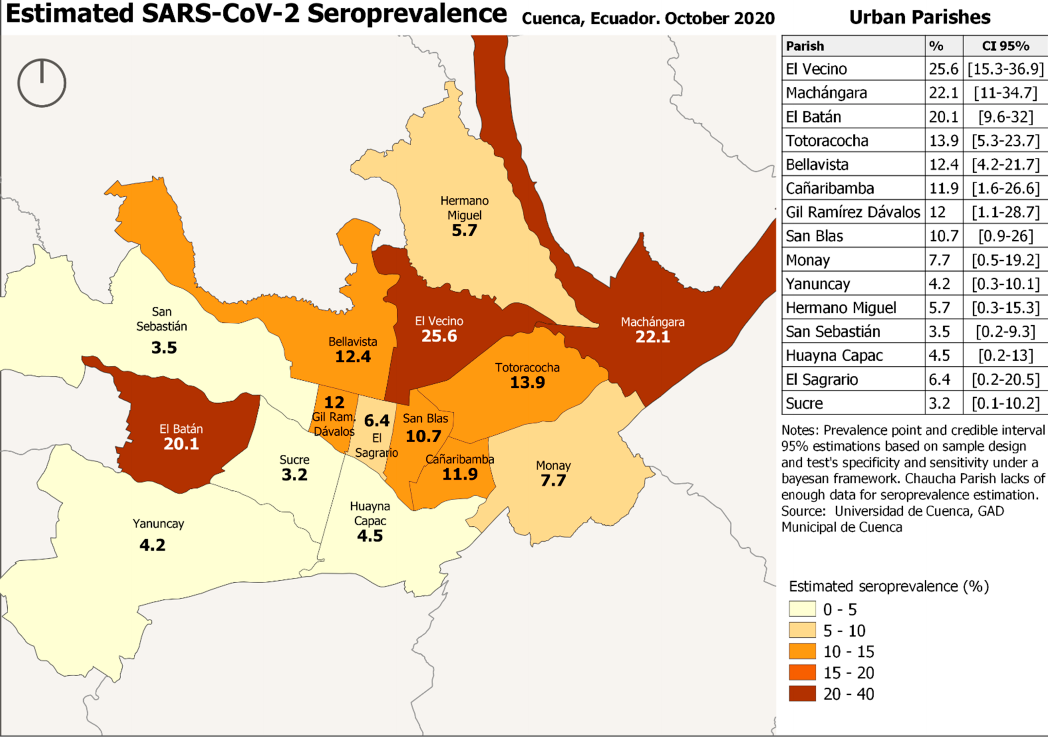
Figure 3. Estimated SARS-CoV-2 Seroprevalence, Cuenca, Ecuador 2020 Urban parishes.